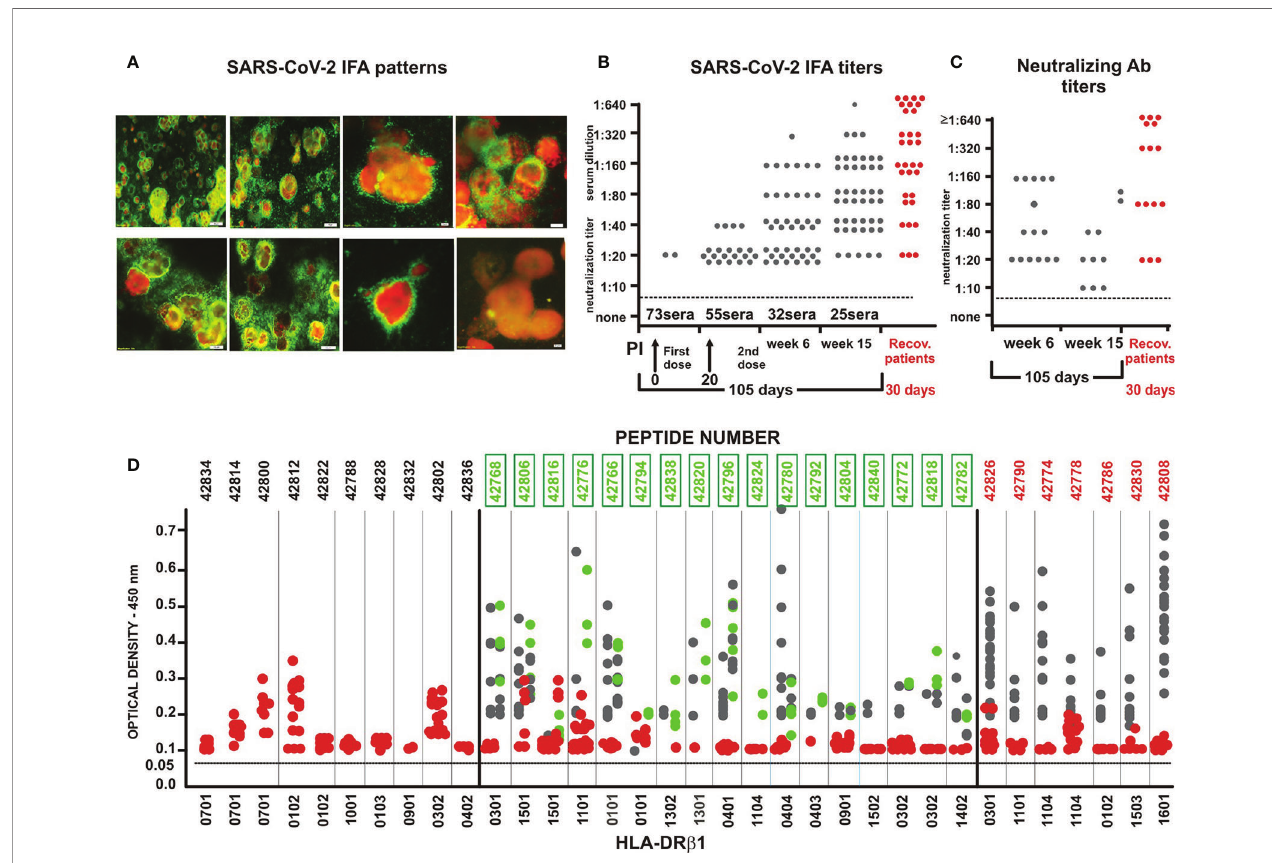
FIGURE 3 | Immunological assays. (A) IFA patterns showing intracytoplasmic fl uorescent dots (bright yellow) recognised by immunised Aotus monkey sera reacting with SARS-CoV-2 human/Medellin/UdeA1/2020 strain proteins in VERO cell cytoplasm. The last image, bottom right, shows negative control serum. (B) Aotus sera IFA titre evolution 6 weeks and 15 weeks post-initial (pi) immunisation in 2-fold dilution, beginning at 1:10 dilution. Red circles represent IFA of COVID-19-recovered human serum at different dilutions. (C) Aotus sera LiViNAb titres 6 and 15 weeks pi immunisation. Red circles represent NAb from COVID-19-recovered human serum at different dilutions, 4 weeks after disease onset. (D) OD density for ELISA reactivity with native peptides (1:100 dilution) - 6 th week (grey balls), 15 weeks after fi rst immunisation (green) and with COVID-19-recovered human serum